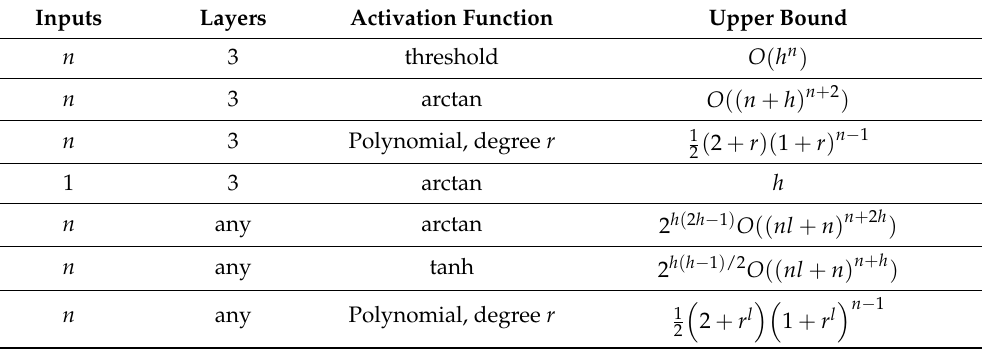
Table 5. Runtime complexity analysis of shallow and deep CNN architectures (adapted from study [59]). Here l = hidden layer, h = hidden units, n = inputs, and r = degree of the polynomial.